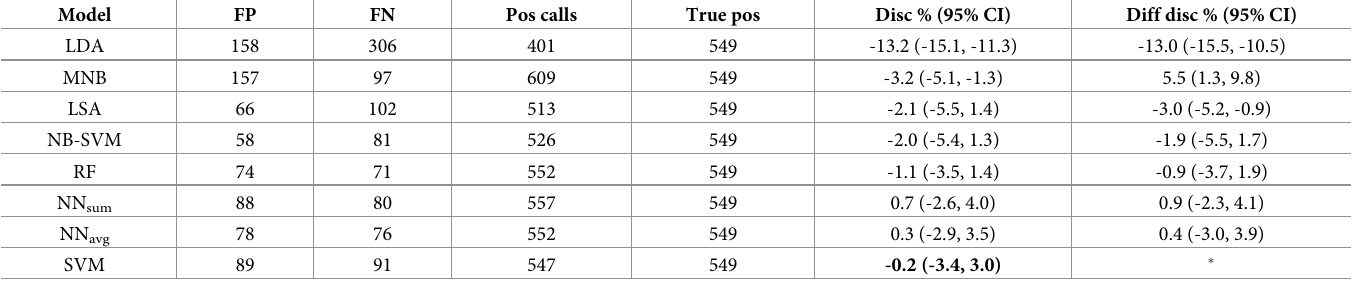
Table 3. Mean prevalence-related metrics for our 8 models across the 10 train-test splits. Metrics included are false positives (FP); false negatives (FN); number of pos- itive calls (Pos calls); number of true positives in the test set; discordance; and the difference in discordance from the least discordant model, the SVM. Here, discordance is the difference between the predicted percentage positive and the true percentage positive. Simultaneous confidence intervals are multiplicity-adjusted to control